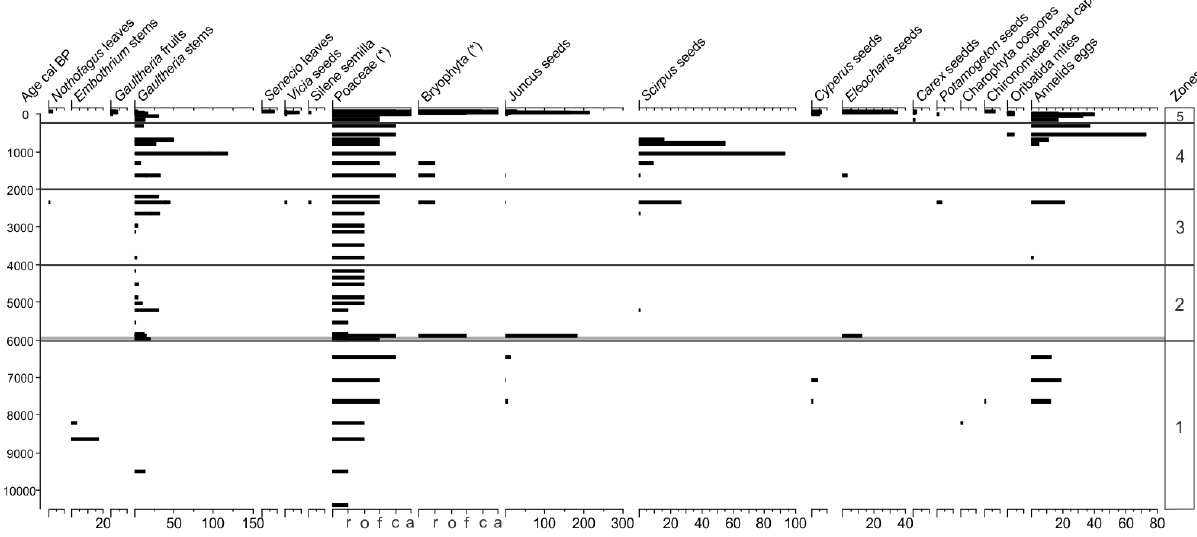
Figure 7. Península Avellaneda Bajo (PAB) macrofossil diagram, expressed in terms of concentration (remains per 10 cm 3 ), or (*) relative abundance (r = rare, o = occasional, f = frequent, c = common, a = abundant. The grey line at 5800–6000 cal yr BP represents the tephra